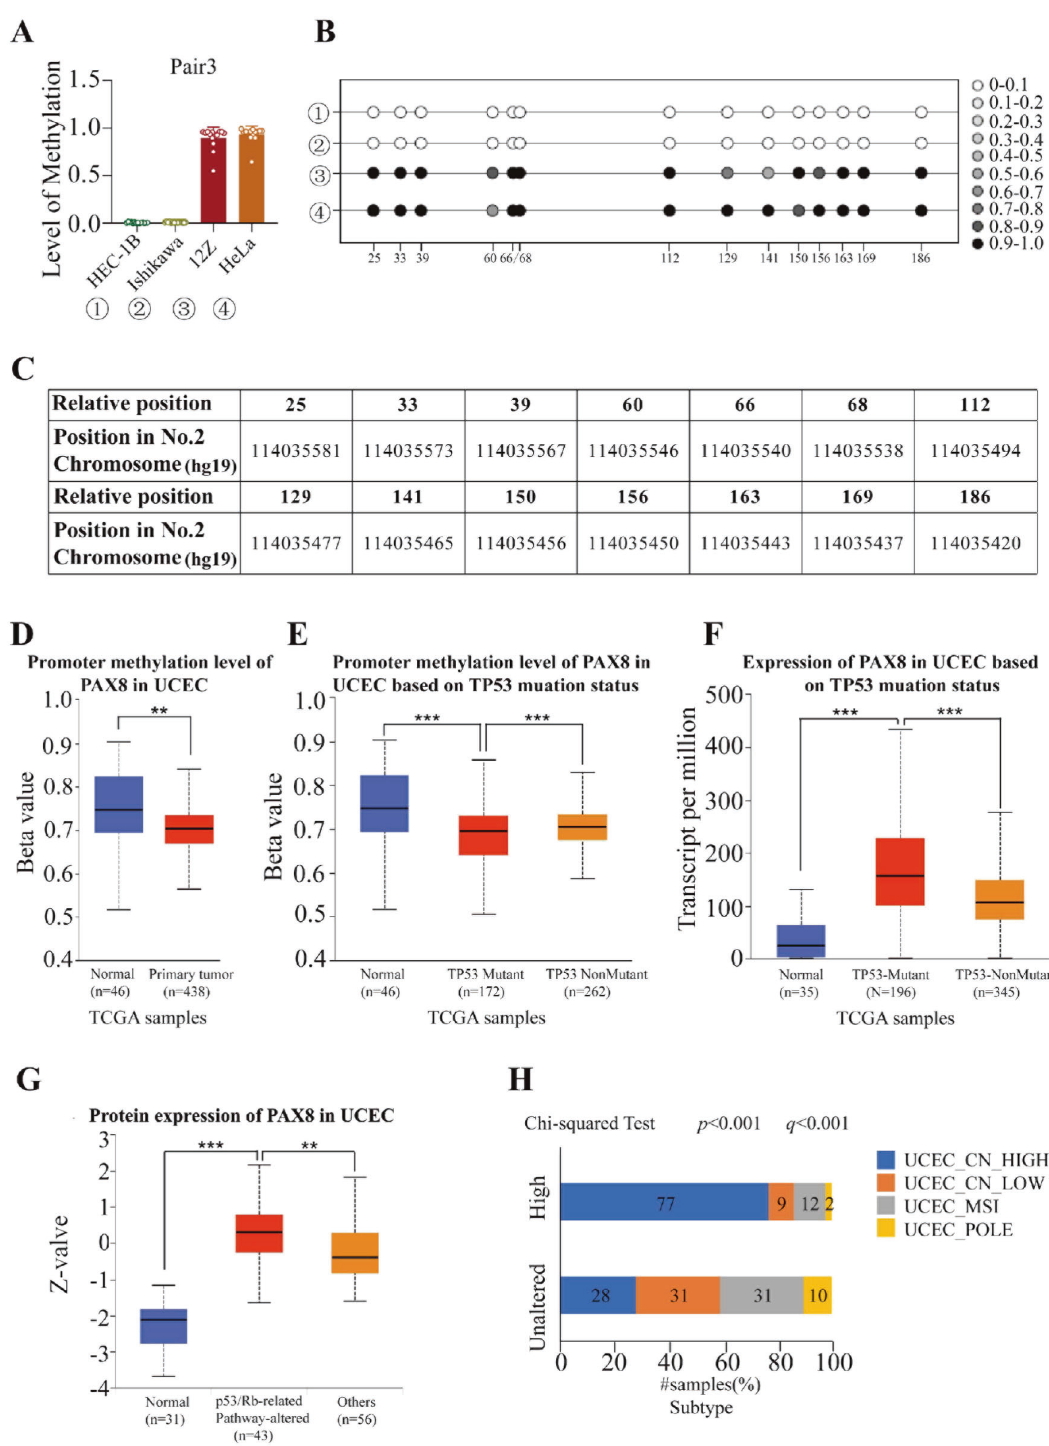
Fig. 2 Relationship between methylation level of PAX8 and TP53 mutation (CNH) in molecular subtyping of UCEC. A The methylation levels of PAX8 (pair3) in HEC-1B, Ishikawa, 12Z, and HeLa cells were detected by bisul fi te conversion sequencing. B Schematic diagram of methylation information of all sites in pair3. C Statistical table of methylation information for all sites in pair3. D Promoter methylation level of PAX8 in UCEC was analyzed by TCGA samples. E Promoter methylation level of PAX8 in UCEC based on TP53 muation status was analyzed by TCGA samples. The Beta value indicates level of DNA methylation ranging from 0 (unmethylated) to 1 (fully methylated). F Expression of PAX8 in UCEC based on TP53 muation status was analyzed by TCGA samples. G Protein level of PAX8 in UCEC based on p53-related pathway. H The proportion of PAX8 copy ampli fi cation/mRNA upregulation (Altered group) in four molecular subtypes of endometrial cancer. * p < 0.01, ** p < 0.005, *** p < 0.001.